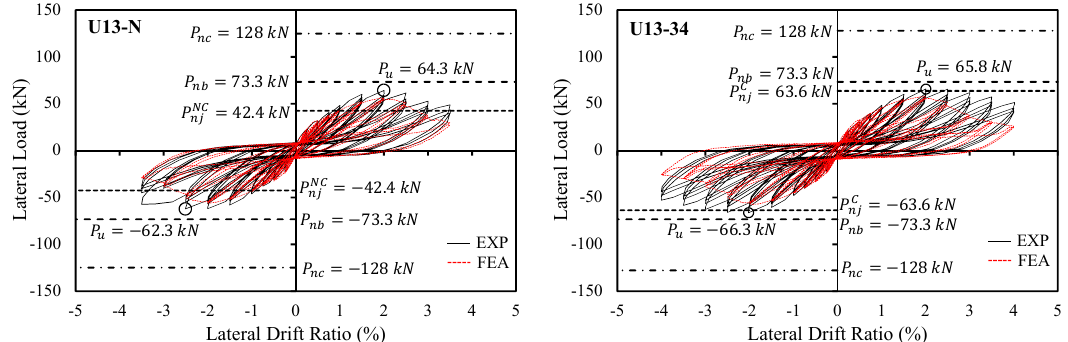
Figure 8. Experimental and analytical lateral load–drift ratio relationships.